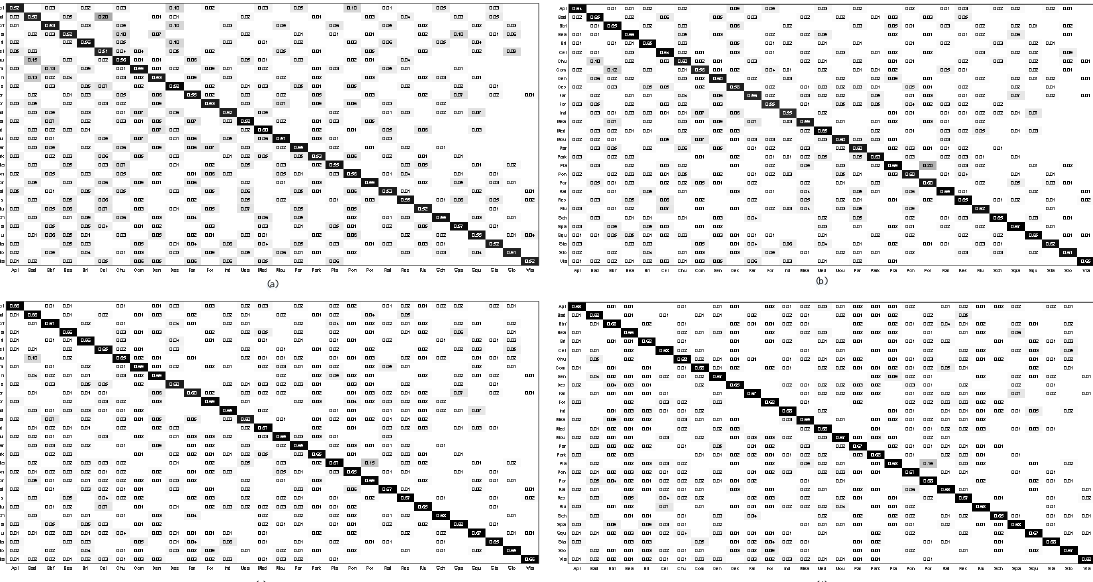
Figure 9. The confusion matrix of 50 sample training sets of AID data set, ( a ) MARTA-GAN; ( b ) sifting GAN; ( c ) SPG-GAN; ( d )